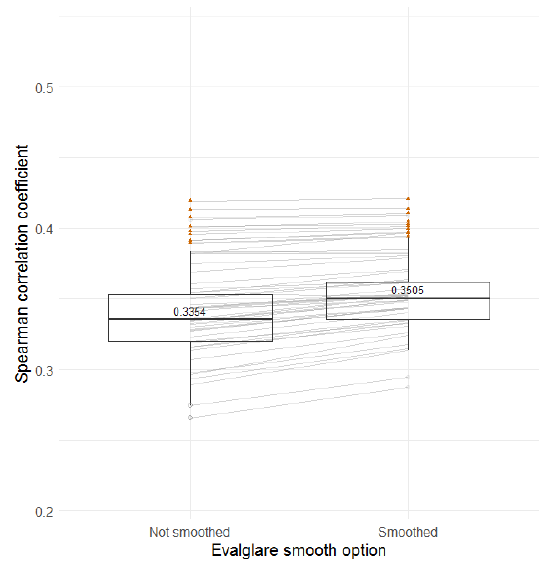
Figure 32. Boxplots of Spearman rho for the non-smooth/smooth parameter (field study).